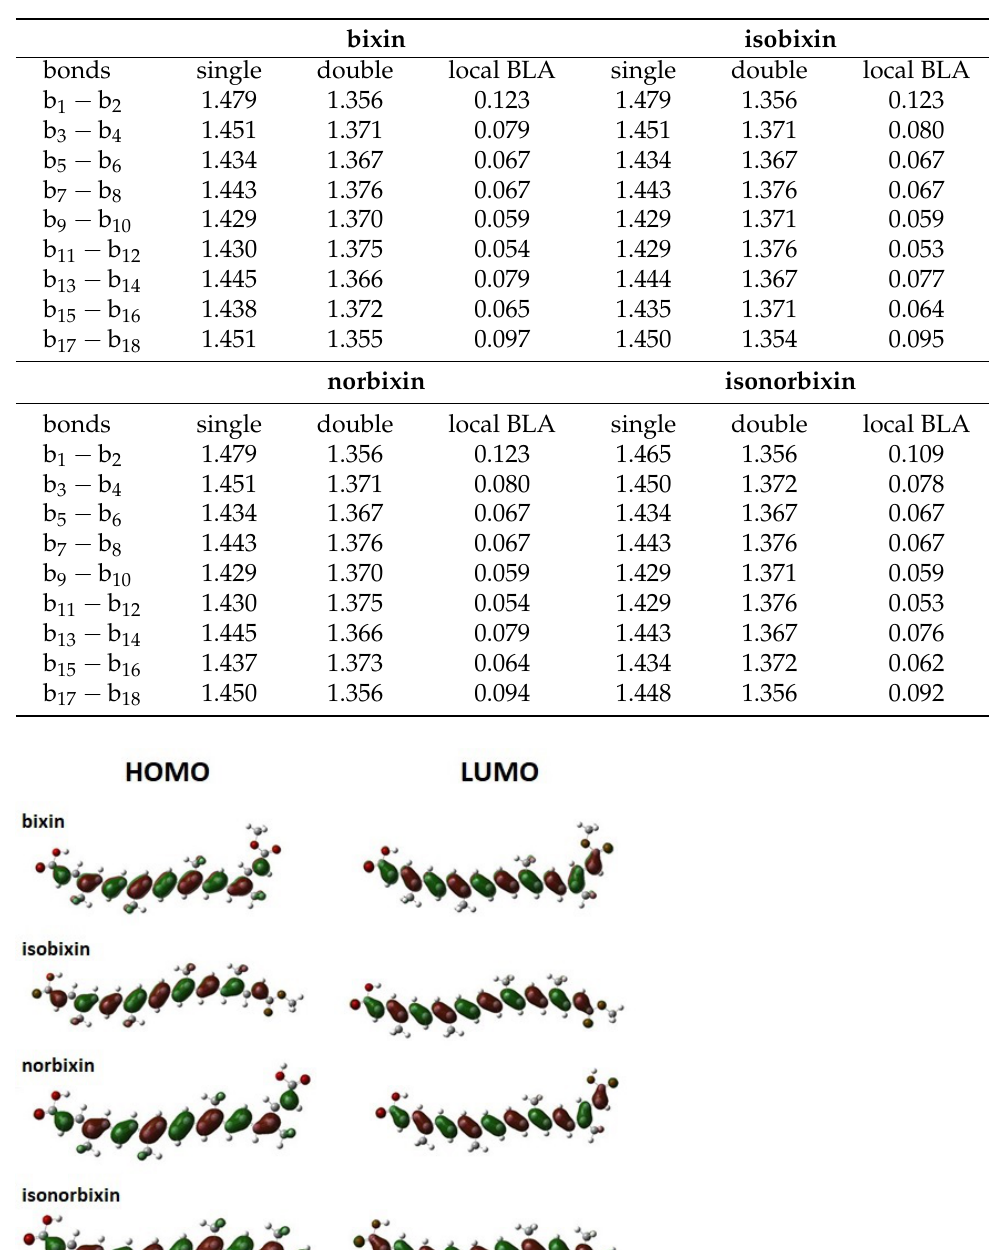
Table A1. Single-double bonds and local BLA values (Å) of the molecular dyes in gas phase. These results were obtained by employing the B3LYP/6-31+G(d,p) level of theory.